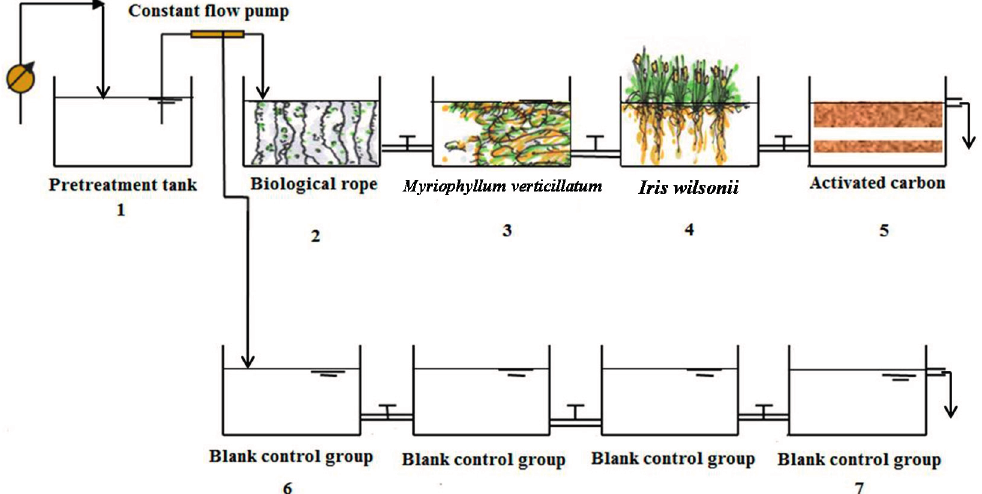
Figure 1. Schematic diagram of the experimental